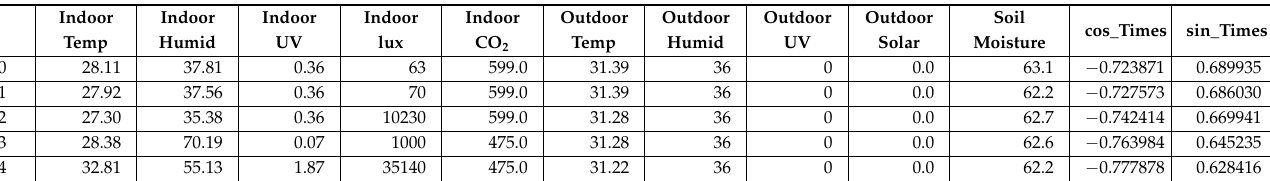
Table 4. Sample of the processed